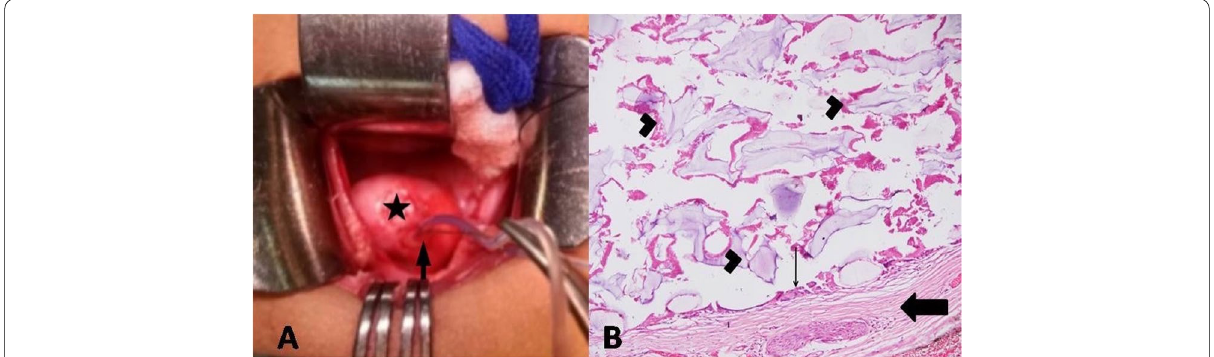
Fig. 2 A Intra operative findings of a large granuloma (star) encasing the right ureteric orifice (arrow showing the exit of a catheter from the ureteric orifice). B Abundant amorphous foreign body material (arrow heads )with giant cell reaction (arrow) within the fibromuscular wall (bold arrow), H&E, ×